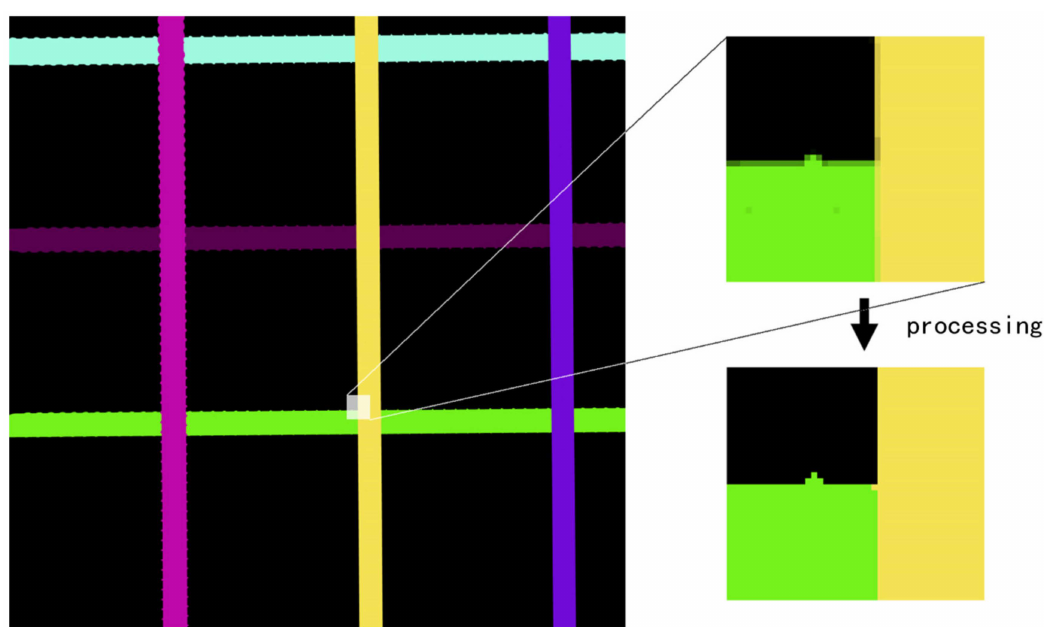
Figure 8. Transition color processing.